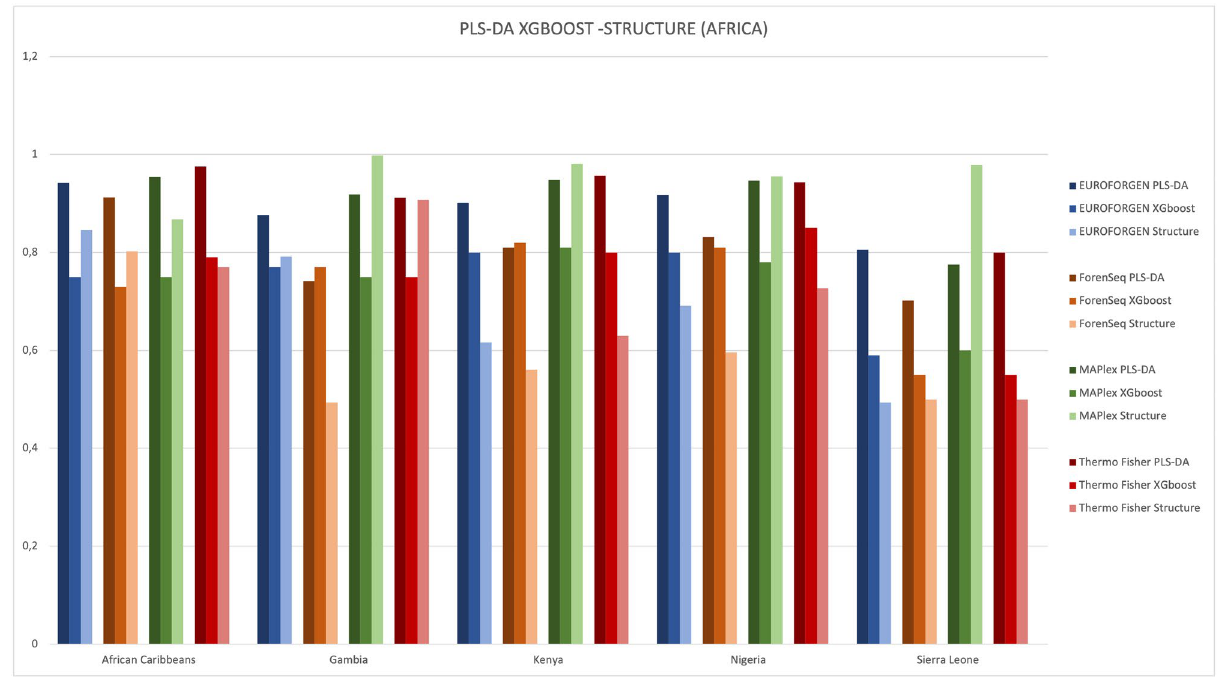
Figure 15. Comparison of AUC values obtained from PLS-DA, XGBoost and STRU CTU RE model for African